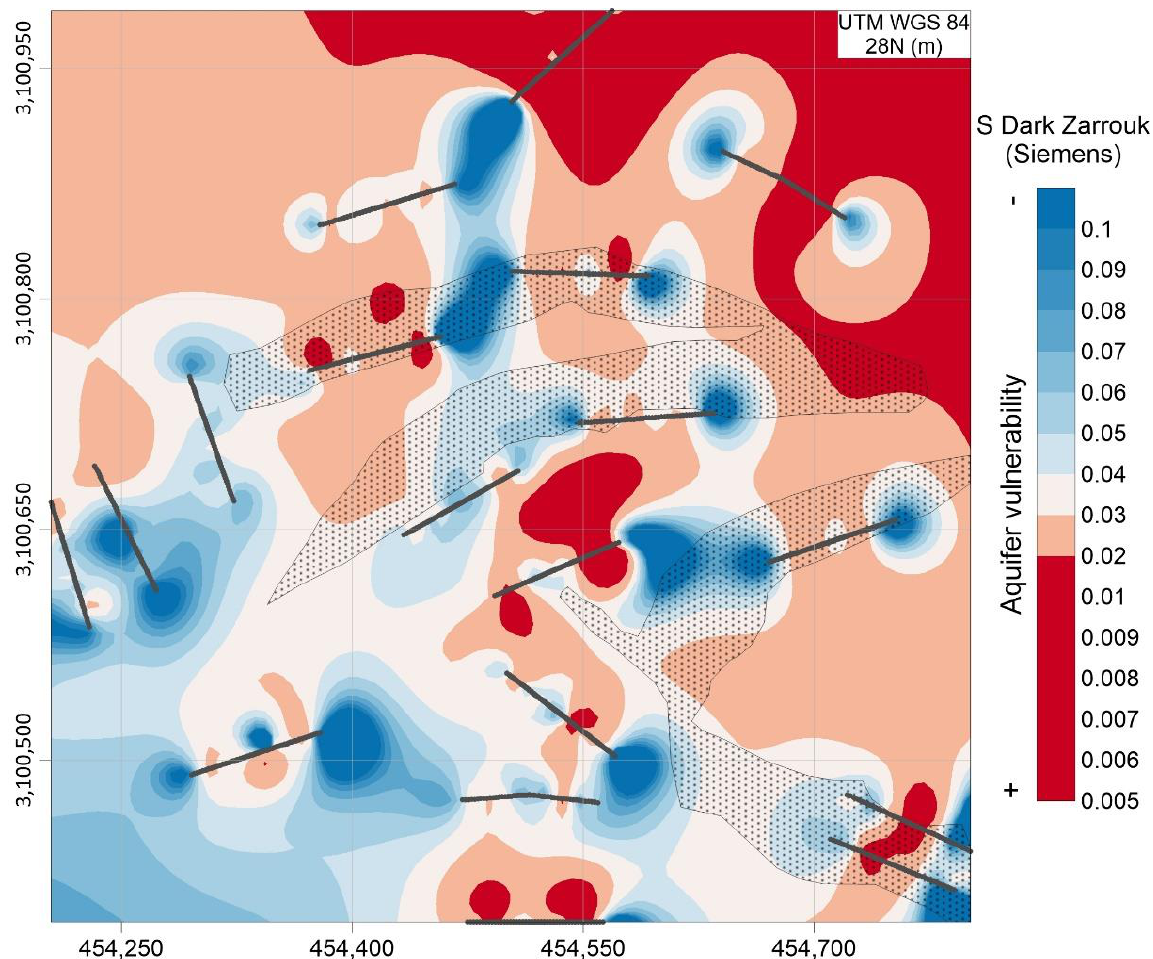
Figure 5. Spatial distribution of longitudinal conductance (S) until 20 m depth of the Bandama’s site. ERT profiles location is presented as dark grey lines and transported soil as dotted areas.